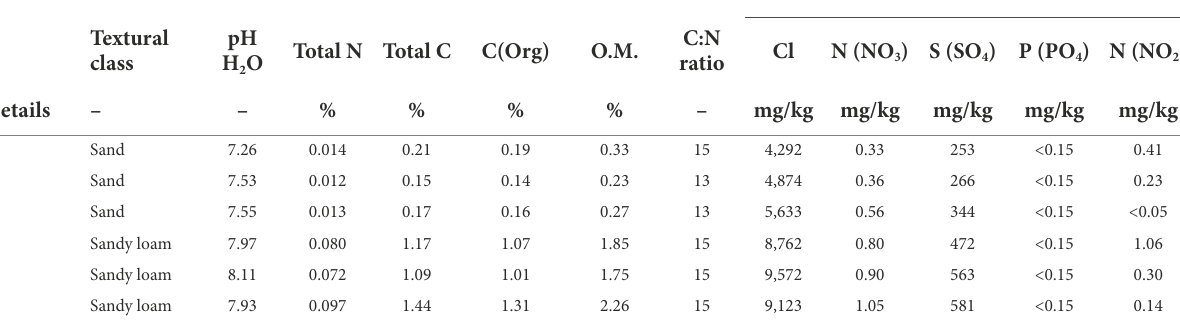
TABLE 1 Chemical properties of rhizosphere sediment samples from six different Sporobolus anglicus plants from October